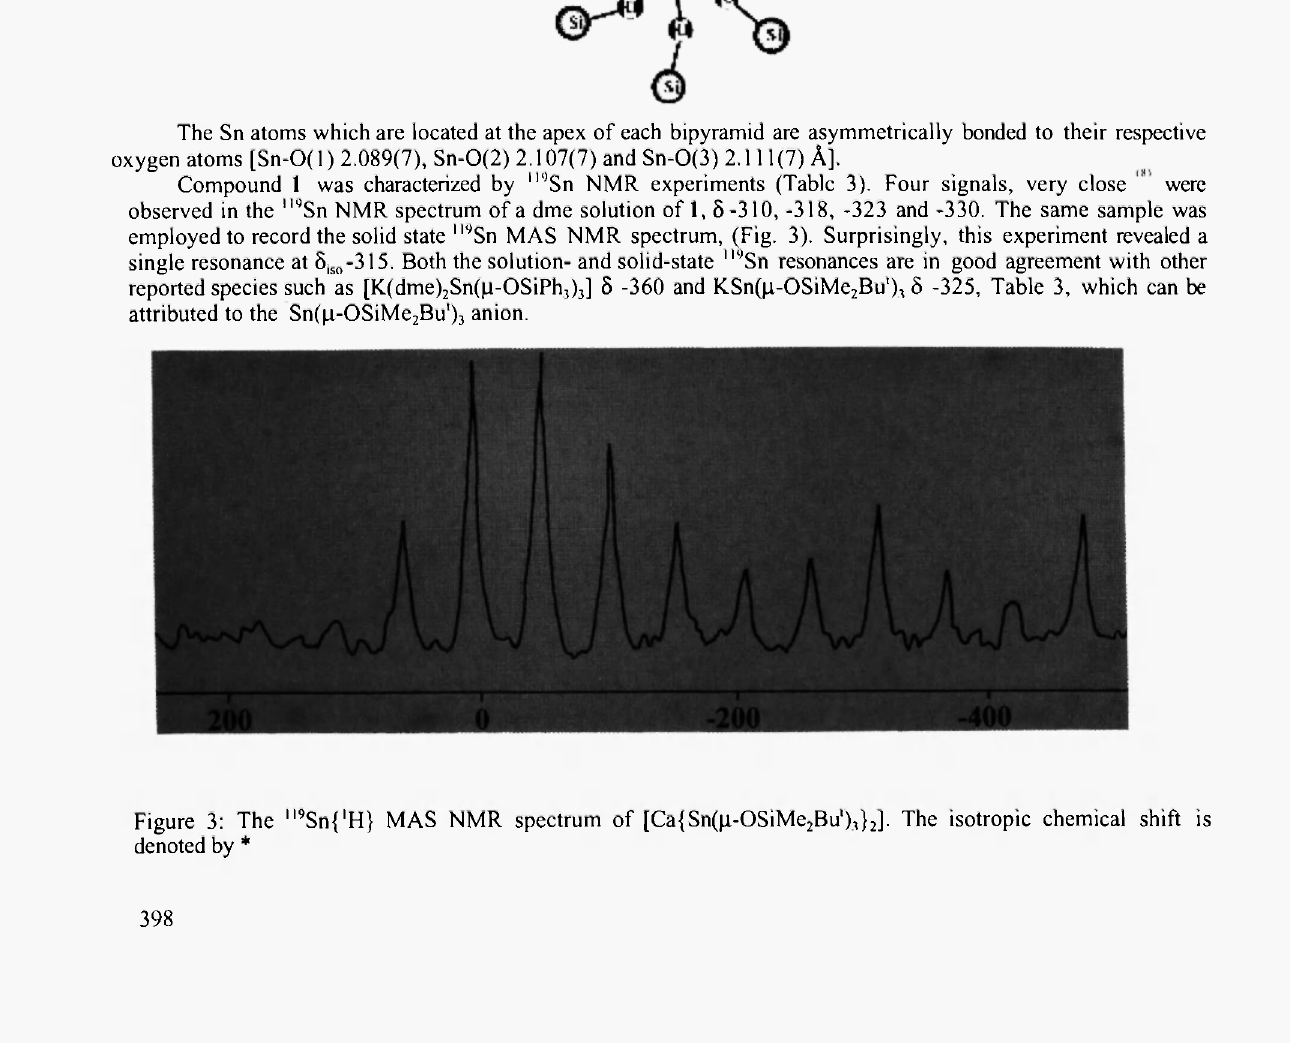
Figure 3: The " 9 Sn{'H} MAS NMR spectrum of [Ca{Sn^-OSiMe 2 Bu'),} 2 ]. The isotropic chemical shift is denoted by